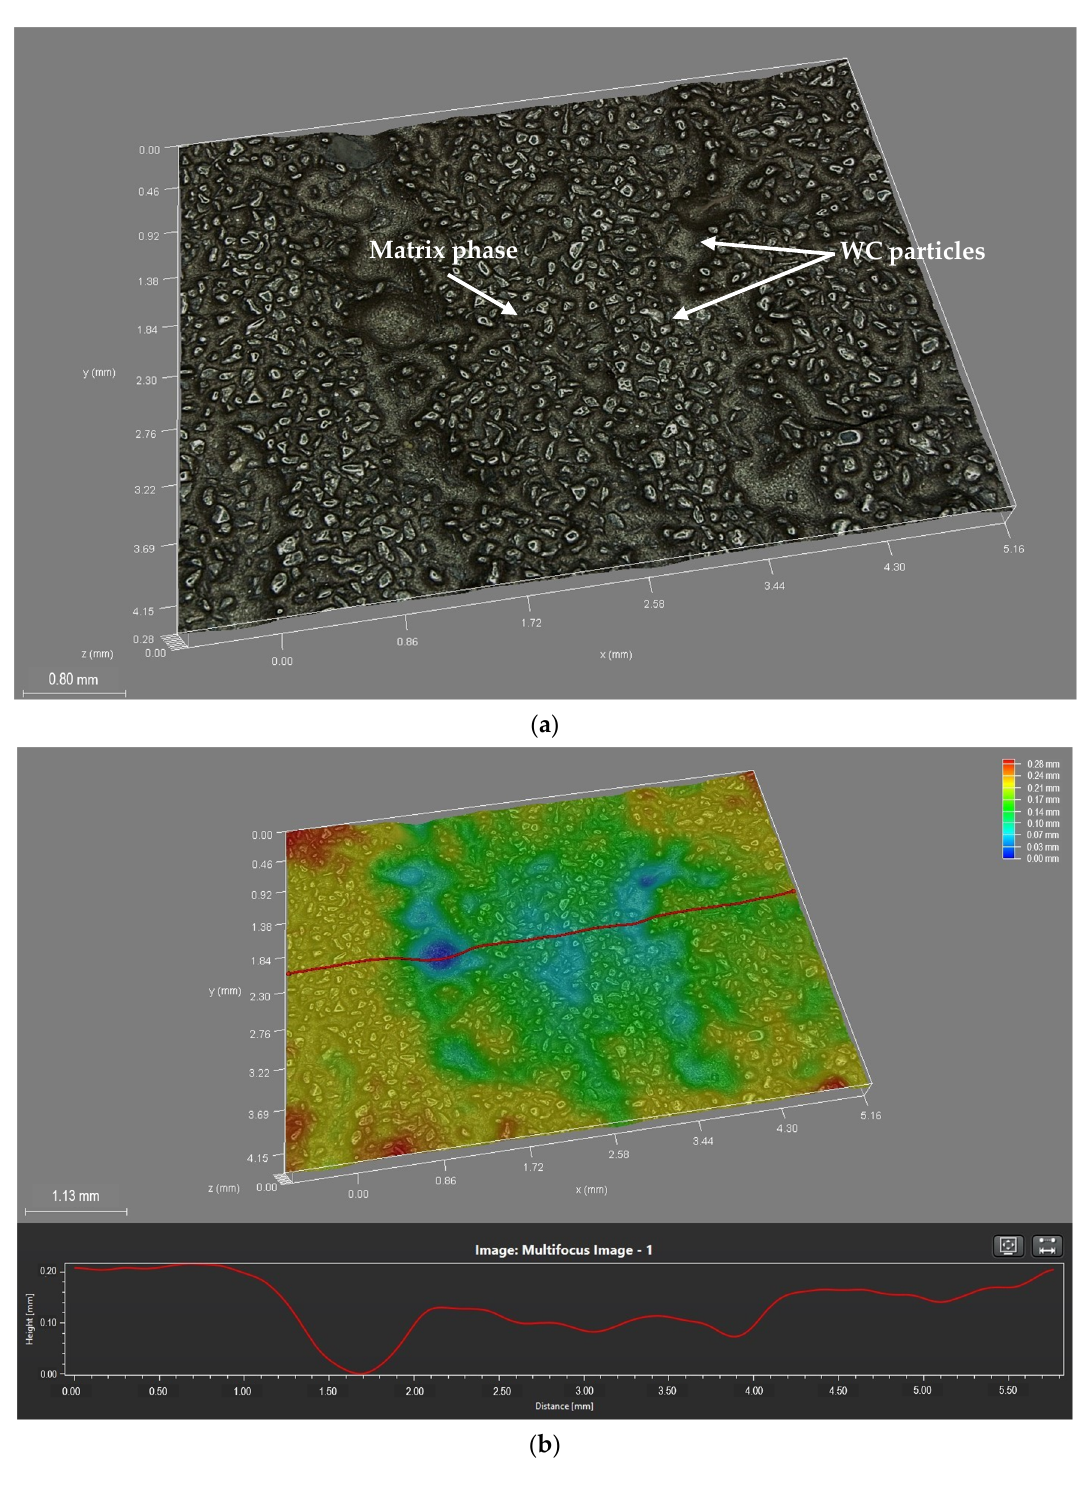
Figure 13. Images of surface layer of sample 4-PG after abrasive wear resistance test ( a ) post-abrasive wear test surface showing dispersed WC particles and the matrix phase ( b ) depth map showing the depth of abrasion on the surface of the layer.